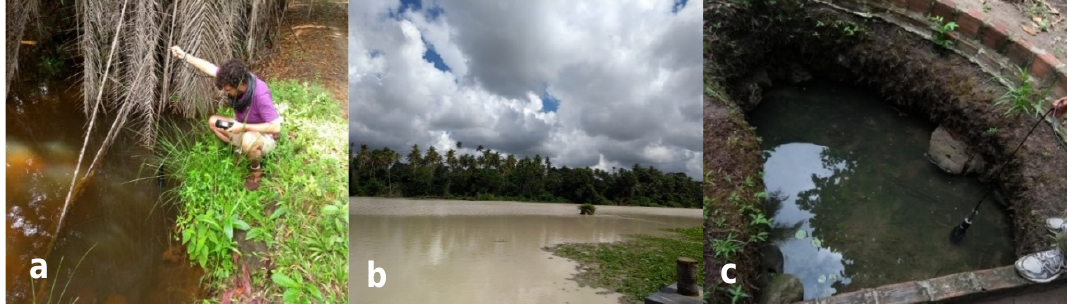
Figure 4. Sampling sites with anomalous color: ( a ) in the creek (SN3), ( b ) in the drainage pond of an area with sand exploration (SN 11), and ( c ) in an open cacimba (SN13).